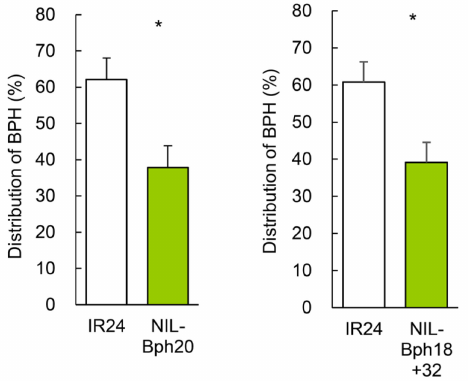
Figure 9. Settling preference of BPH on NIL-Bph20 or NIL-Bph18 +32 over IR24. Same as in Figure 2. Statistical analysis was performed using Student’s paired t -test (N = 4). * p <